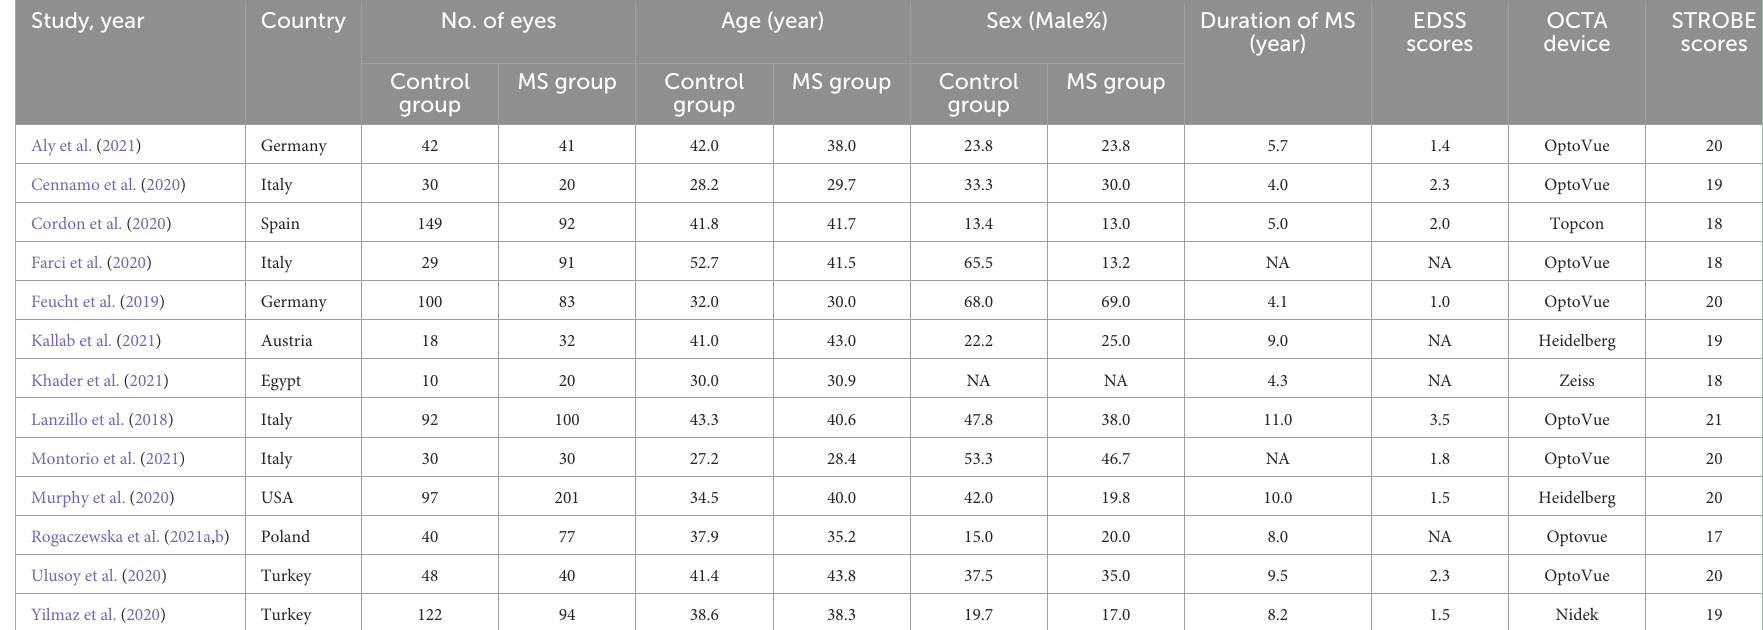
TABLE 1 Characteristics of the included studies.